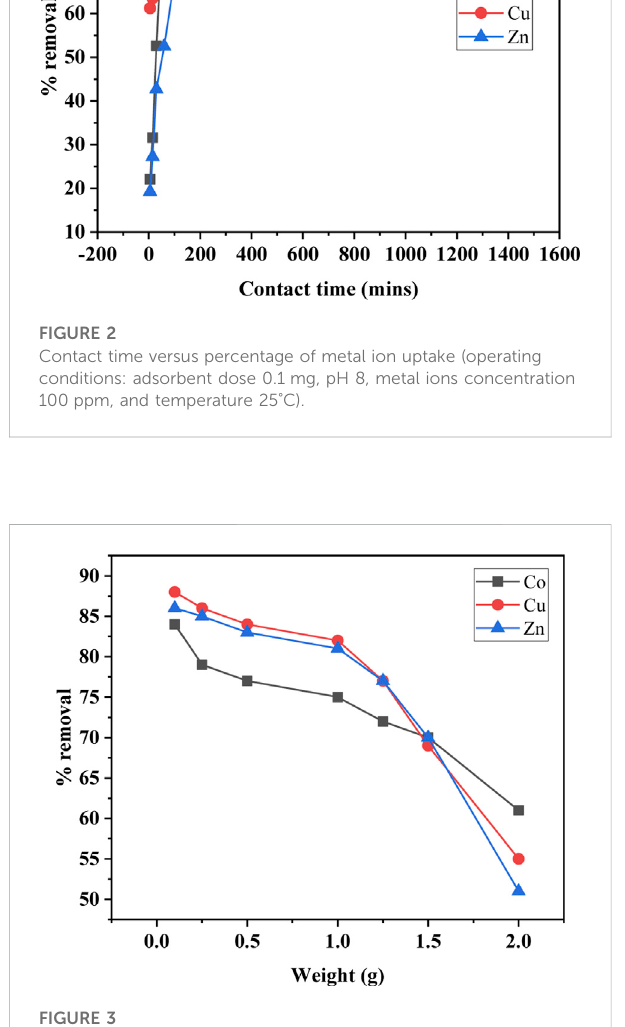
Schiff base weight versus the rate of metal ion uptake (operating conditions; metal ion concentration 100 ppm, pH 8, contact time 1.5 h, and temperature 25 ° C).